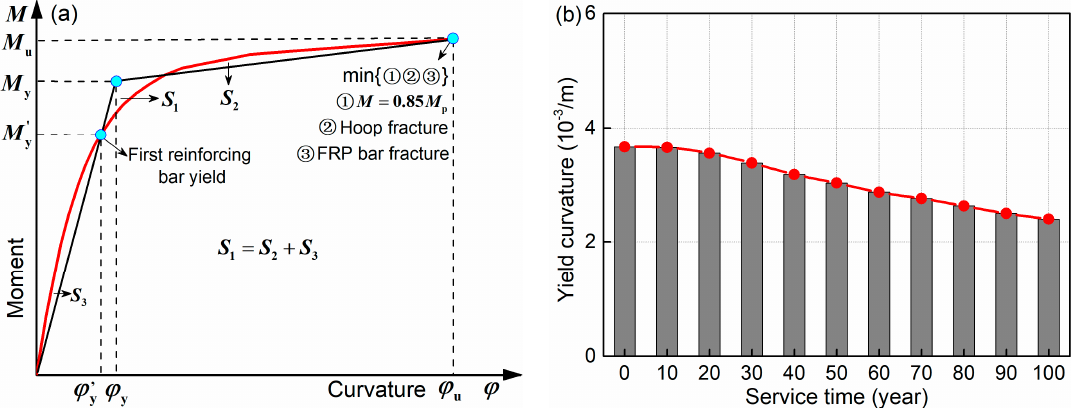
Figure 16. Yield curvature of the cross section: ( a ) definition; ( b ) time-dependent values.